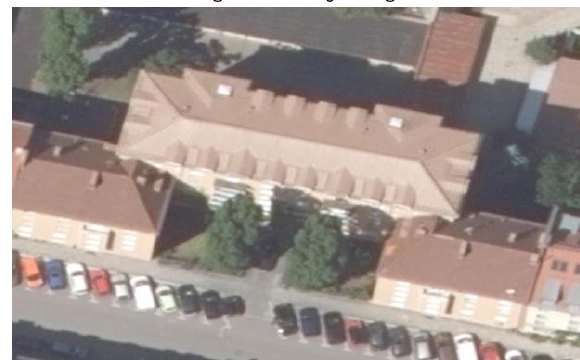
Figure 22. ATKIS-DOP presentation with